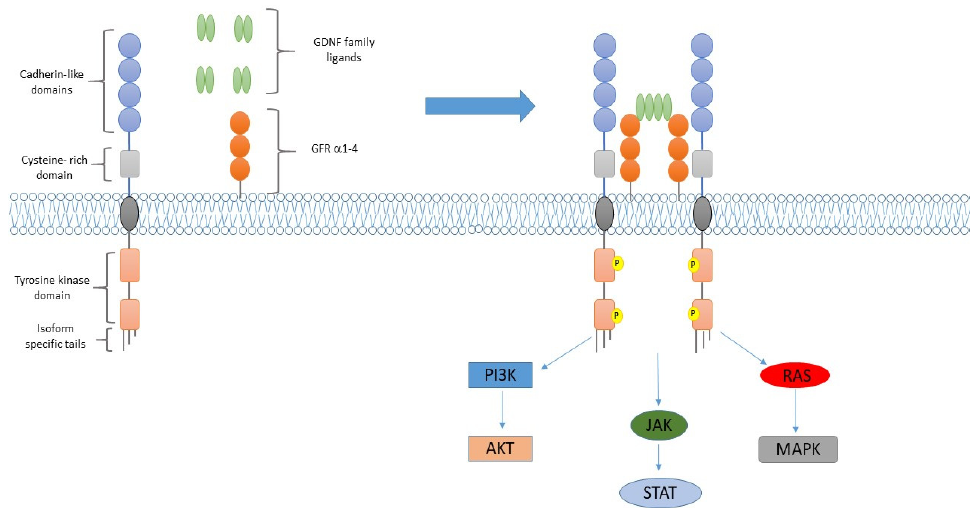
Figure 1. RET structure and its activation. The RET protein includes an extracellular, a transmembrane and an intracellular region. The RET extracellular region consists of four highly repeated domains (cadherin-like domains) as well as a cysteine-rich domain. The transmembrane domain links the extracellular region to the intracellular tyrosine kinase domain (TKI), which ends with isoform specific tails (on the left). Glial cell line-derived neurotrophic factor (GDNF) family lig- ands and GDNF family co-receptors (GFR α 1-4) play a central role in RET activation. The binding of the GDNF ligand to the GFR co-receptor determines the construction of a ternary complex which includes RET, the GDNF ligand and the GFR co-receptors. The newly formed ternary com- plex leads to RET TKI domain phosphorylation. Phosphorylated RET TKI domains then activate the downstream signalling pathways implied in cell proliferation, growth, differentiation and sur- vival such as RAS/MAPK, PI3K/AKT, PKC and JAK-STAT (on the right). RET Rearrangements in NSCLC RET rearrangements are rarely found in NSCLC patients (1–2%). In most cases, pa- tients harboring RET alterations do not display any concurrent oncogenic driver. How- ever, some small retrospective studies have reported MET amplification and EGFR muta- tions in this subset of patients [4,5]. Moreover, a large study also confirmed the co-exist- ence of other genetic alterations in RET+ patients. By analysing 4871 different tumour samples, the co-occurrence of genetic abnormalities has been found in the majority of RET- altered patients (81.8%, 72/88 patients), the most common being TP-53 associated genes (59.1%, 52/88 patients), cell cycle-associated genes (39.8%, 35/88 patients), the PI3K signal- ling pathway (30.7%, 27/88 patients), MAPK effectors (22.7%, 20/88 patients) or other ty- rosine kinase families (21.6%, 19/88 patients) such as FGFR families, EGFR, ALK, HER2, PDGFR α and PDGFR β [6]. Finally, de novo RET fusions are a well described acquired mechanism of resistance to first, second and third generation anti-EGFR TKIs in EGFR mutant NSCLC patients [7,8]. To date, at least 12 fusion RET partner genes have been identified, the most common being KIF5B and CCDC6 (70–90% and 10–25% of all cases, respectively). Despite the breakpoints and fusion partners, a newly formed fusion gene occurs when a 5 ′ sequence encoding for a coiled coil domain of a RET fusion partner jux- taposes with the 3 ′ RET sequence encoding for the intracellular tyrosine kinase domain of RET, which usually preserves its functions. Coiled coil domains of these neo-constituted proteins induce ligand-independent homodimerization and the activation of the RET TKI domain by autophosphorylation, resulting in the constitutive stimulation of downstream signalling pathways [9]. RET rearrangements have been identified in tumour specimens via classic techniques, such as FISH and RT-PCR. Both these techniques, however, display some limits, namely their inability to detect de novo or unknown RET fusion partners. By